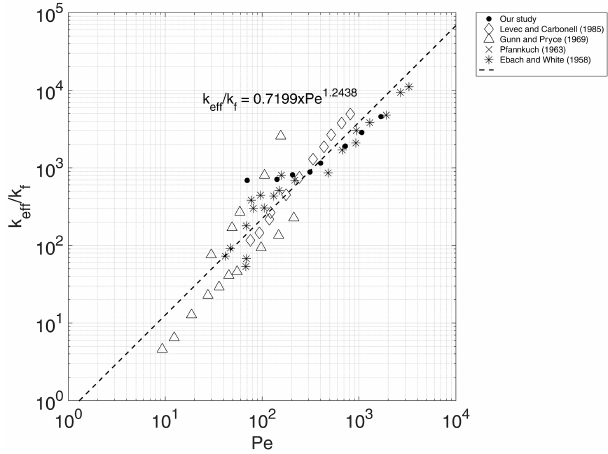
Figure 6. Comparison between the obtained experimental results with other